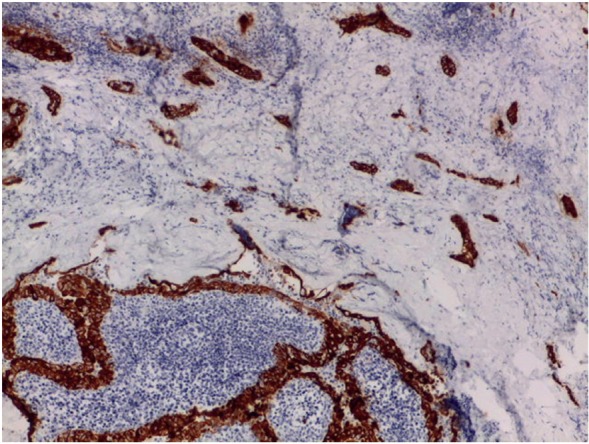
Galectin-3 expression in both areas of Warthin-like tumor and sclerosing ones (Brown staining).